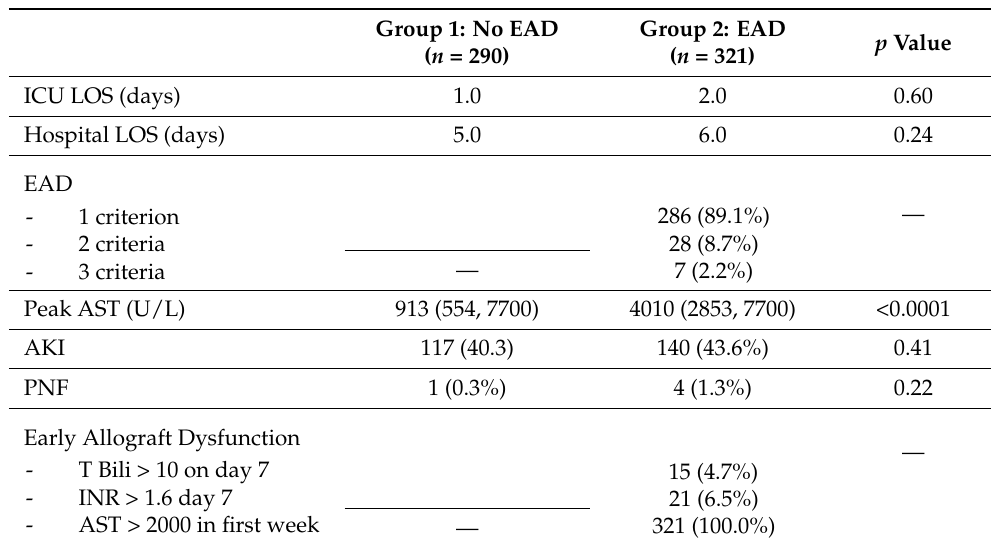
Table 2. Post-transplant